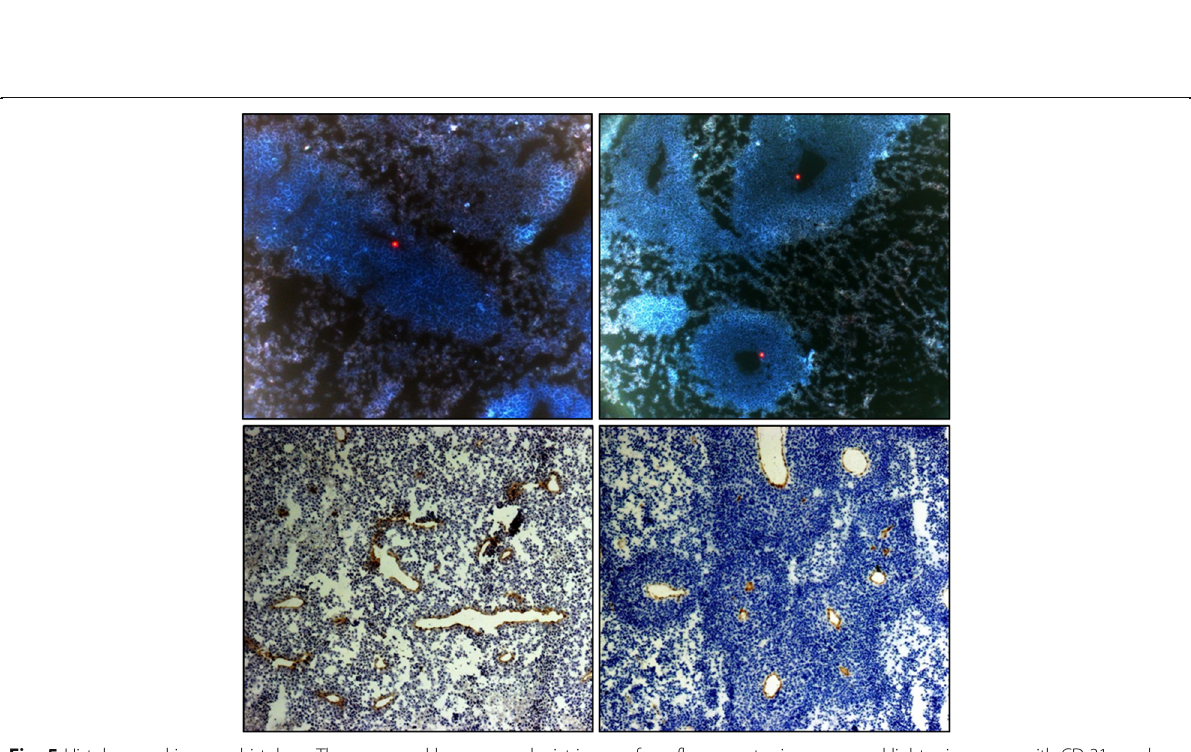
Fig. 5 Histology and immunohistology. The upper and lower rows depict images from fluorescent microscopy and light microscopy with CD-31vessel marker, respectively. The left and right columns depict images of non-co-transplanted and co-transplanted tumors, respectively. In fluorescent histology, one red fluorescent bead is detectable within a part of compact tumor tissue in a non-co-transplanted tumor. In contrast, two fluorescent beads within clear visible vessel lumens in co-transplanted tumor. In light microscopy, the CD-31-positive areas (vasculature) stained in brown, and the gray/blue tumor stromal tissue is visible. In the non-co-transplanted tumor less compact tumor tissue developed and in contrast, brown vessel walls surrounded by blue compact vital tumor tissue in co-transplanted